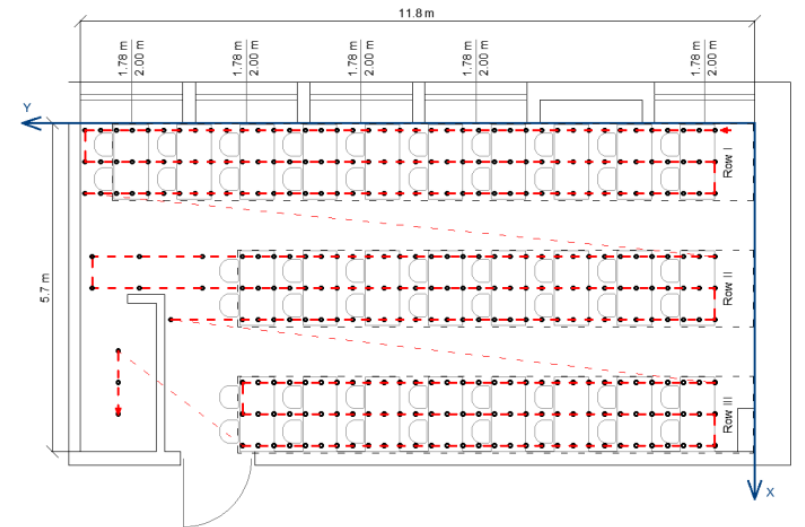
Figure 3. The distribution of measurement